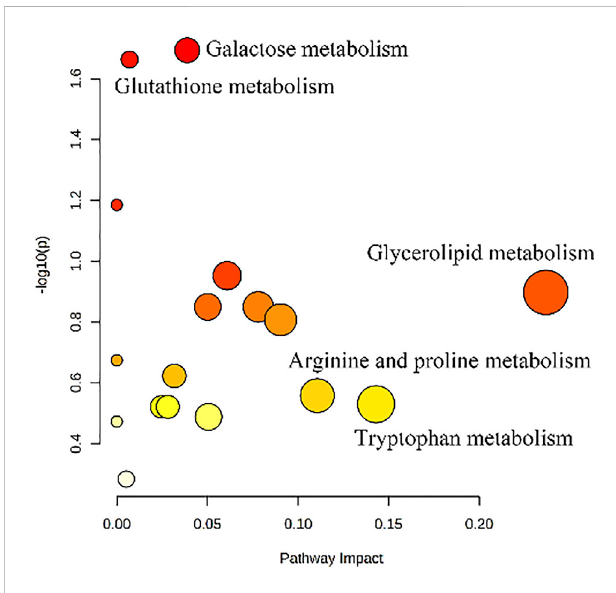
FIGURE 7 Pathways analysis of potential biomarkers.